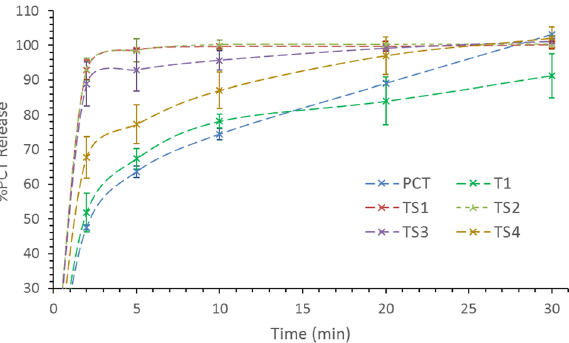
Figure 9. Dissolution profiles showing the %release of PCT from, pure PCT (blue), TS1 trial (red), TS2 (green), TS3 (purple), and TS4 (yellow).